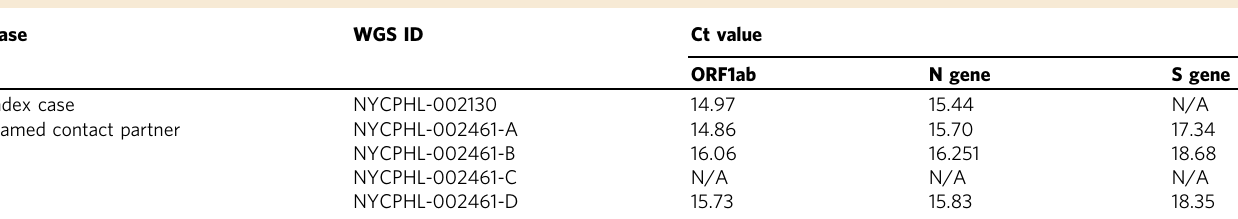
Table 1 Cycle threshold (Ct) values from TaqPath assays from index case (NYCPHL-002130) and named contact partner